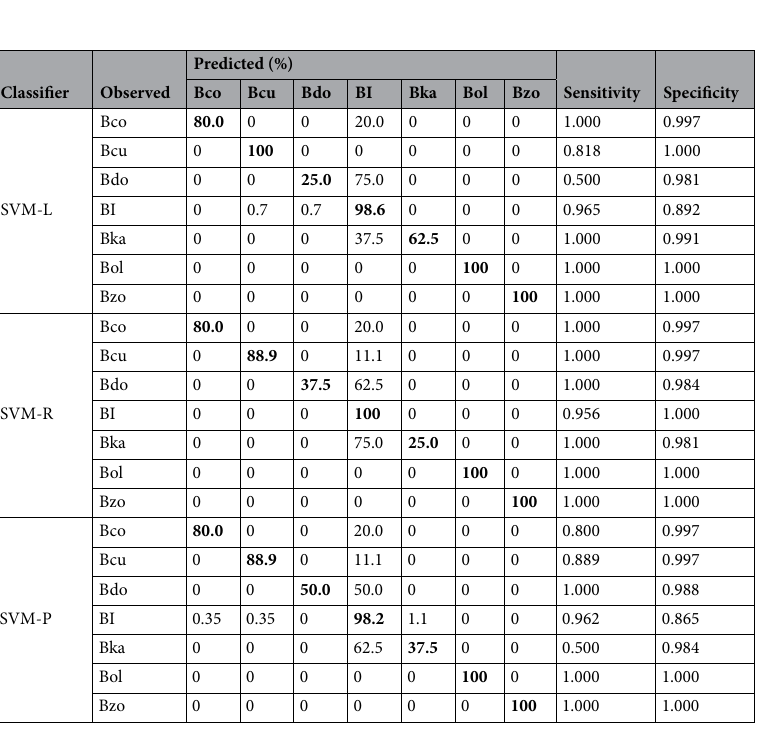
Table 2. Classification results for the SVM classifiers on test dataset of morphometric measurements of Bactrocera spp ., with observed species affiliation in the rows and predicted species allocation in the columns. Correct classification rate appears along the diagonal in bold. Bco— B. Correcta , Bcu— B . cucurbitae , Bdo— B. dorsalis , BI— B. invadens , Bka— B. kandiensis , Bol— B. oleae , Bzo— B. zonata; SVM-L: linear kernel SVM, SVM- R: radial kernel SVM, SVM-P: polynomial kernel